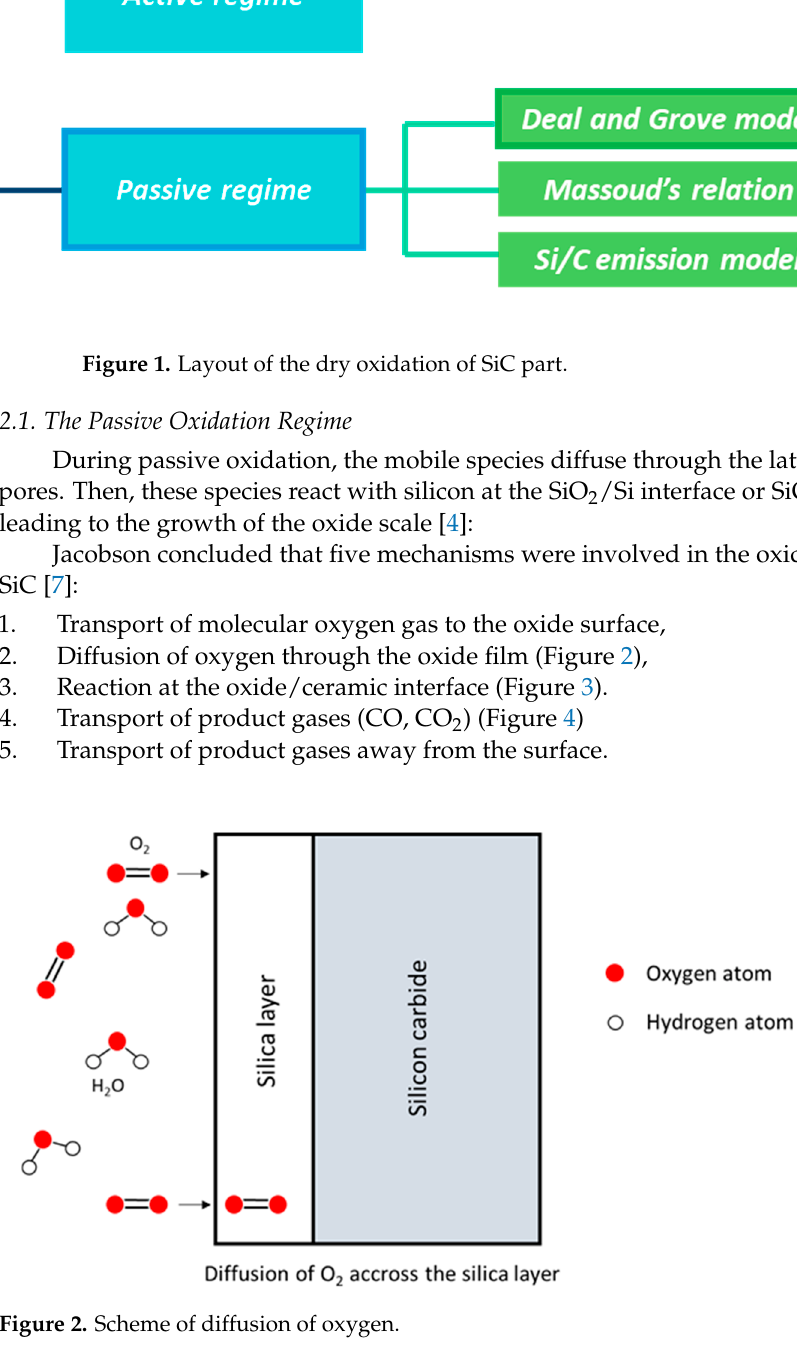
Figure 3. Scheme of the chemical reaction at the interface 4.